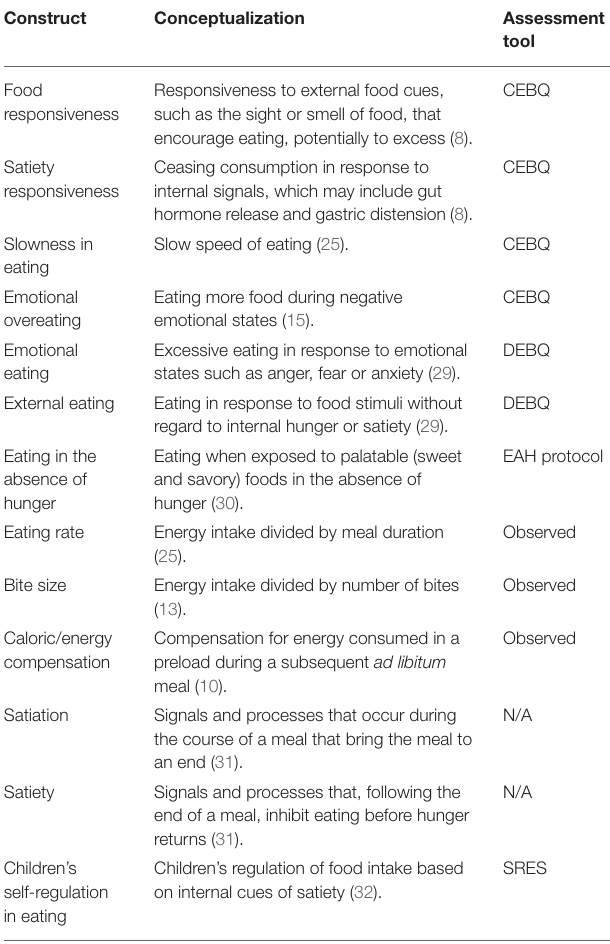
TABLE 1 | Conceptualizations and assessment tools of